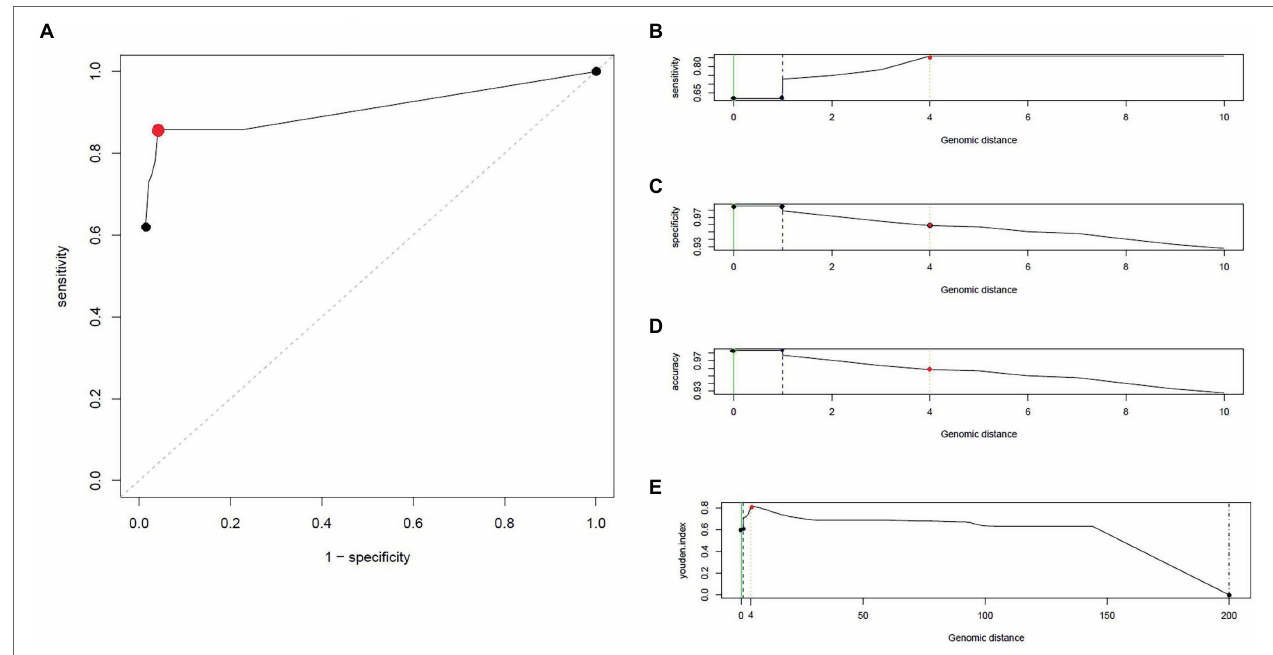
FIGURE 5 | Different Youden indicators calculated using similarity matrix of CNPA strains, generated during SNP analysis. In (A) , an ROC curve showing the relationship between clinical sensitivity and specificity for every possible SNP cut-off. Here an optimal point is represented with red colored dot. SNP cutoff values (Genomic distances) are shown on horizontal axis and different statistical parameters or indicators like Sensitivity, Specificity, Youden’s Index and accuracy are shown on vertical axis in (B-E) , respectively. Based on all the above mentioned indicators genomic distance of 4 SNPs was chosen as overall optimal SNP cutoff value and is highlighted with red colored dot on each